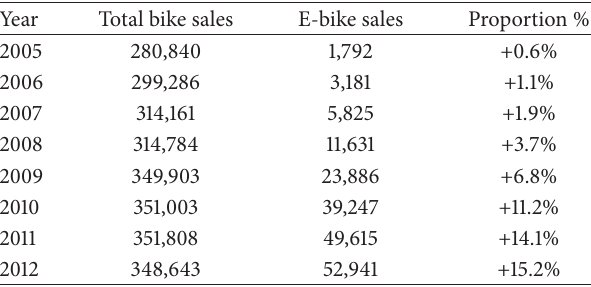
Table 1: Overview of Switzerland’s bicycle market